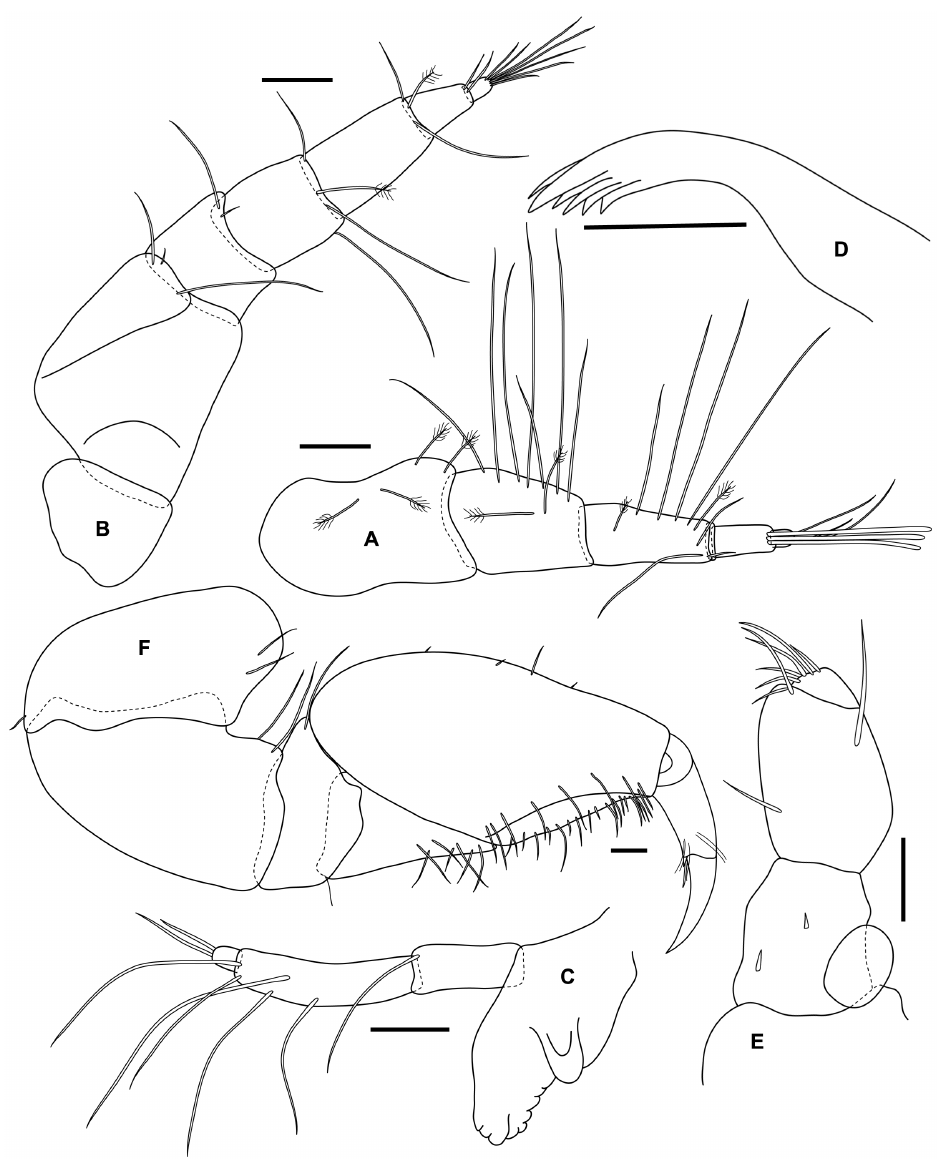
Figure 4. Tinggianthuraalba sp. n., holotype, female, (UKMMZ-1479). All scales represent 0.05 mm. (A) antenna 1, (B) antenna 2, (C) mandible, (D) maxilla, (E) maxilliped, (F) pereopod